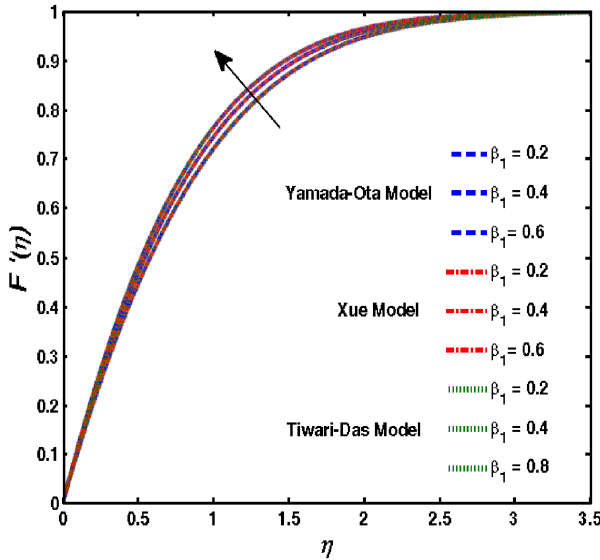
Figure 3. Influence of β 1 on F (cid:48) ( η )